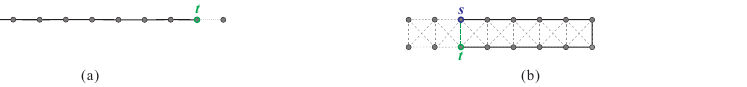
Figure 5. Rectangular supergrid graphs in which there is no Hamiltonian ( s , t ) -path for ( a ) R ( m ,1 ) , and ( b ) R ( m ,2 ) , where solid lines indicate the longest path between s and t